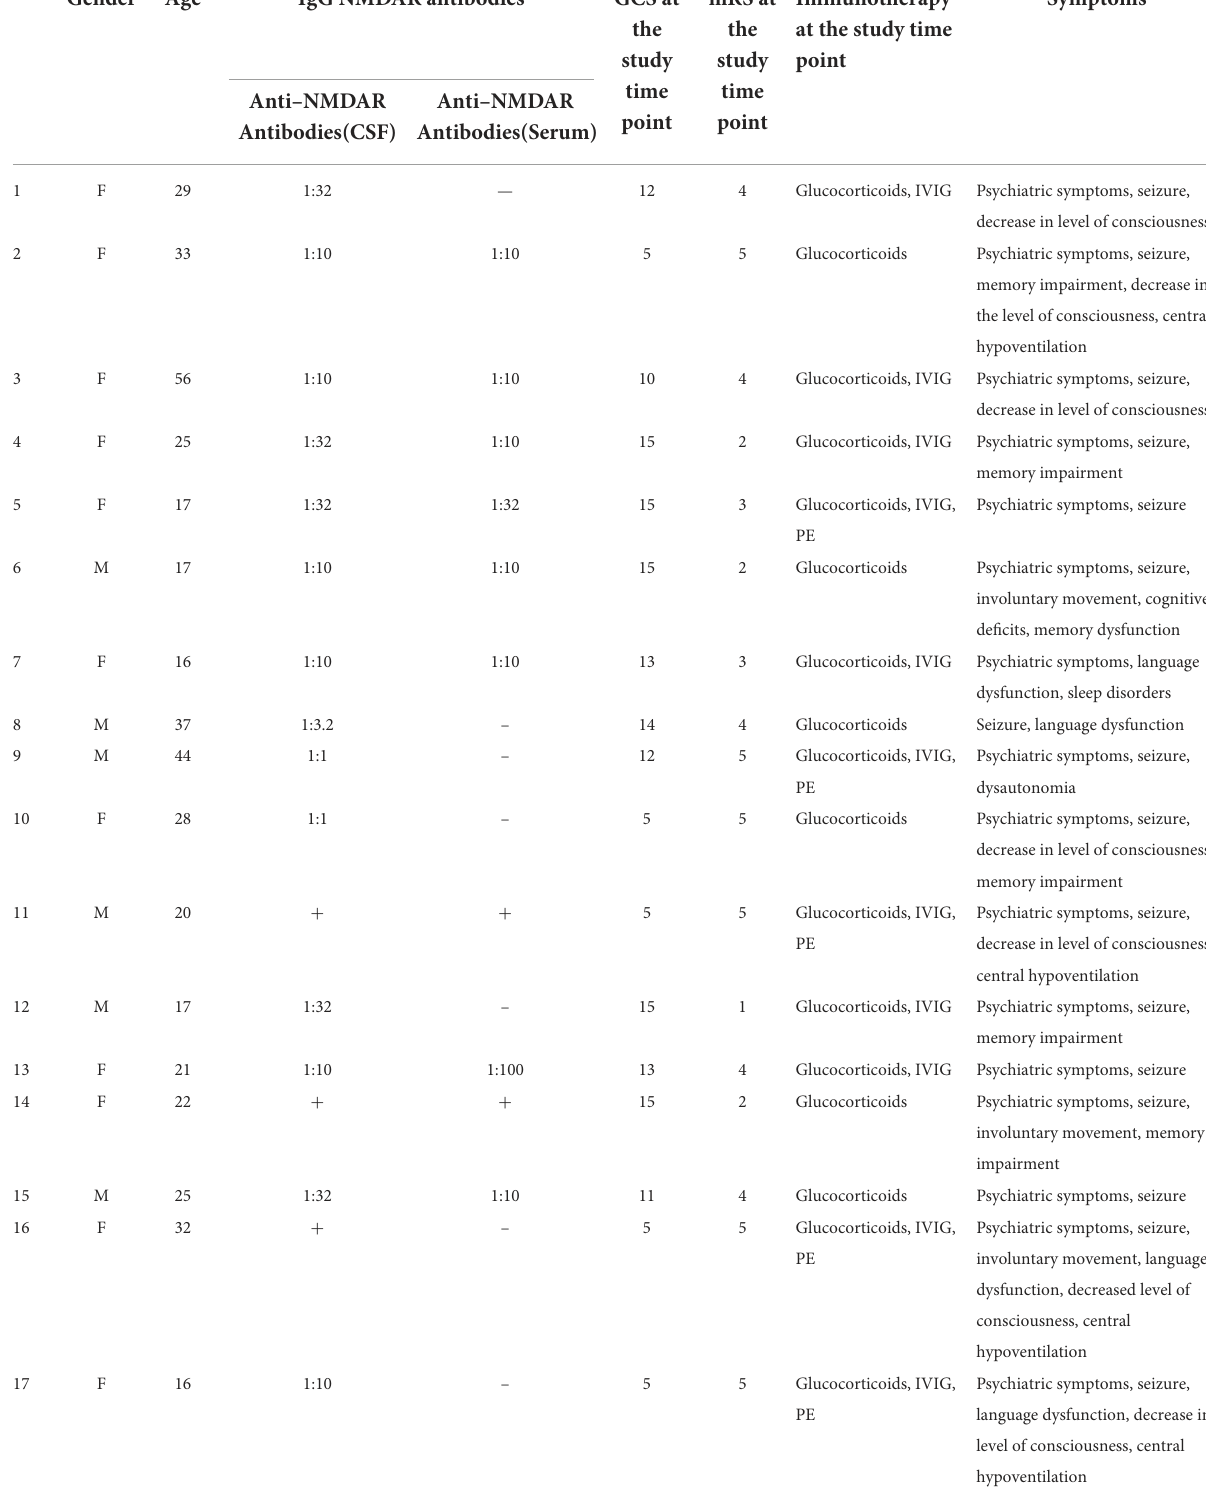
TABLE 1 General information and clinical features of patients with anti-NMDAR encephalitis.